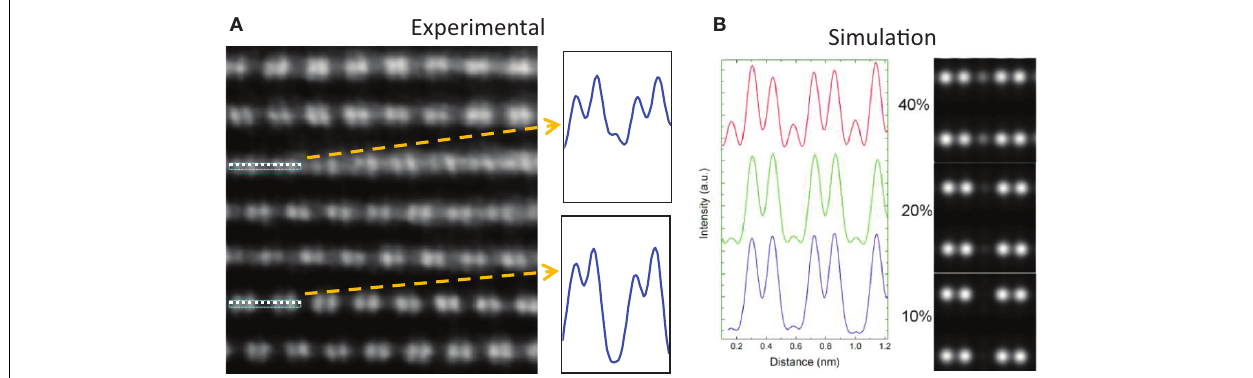
FIGURE 3 | (A) Experimental STEM-HAADF image from [100] zone axis to show local in-plane TM aggregation in the grain bulk. (B) Simulation results to show the changes of STEM-HAADF images with different TM substitutions in the Li column in the TM slab (Gu et al., 2013). Copyright 2013 American Chemical Society.